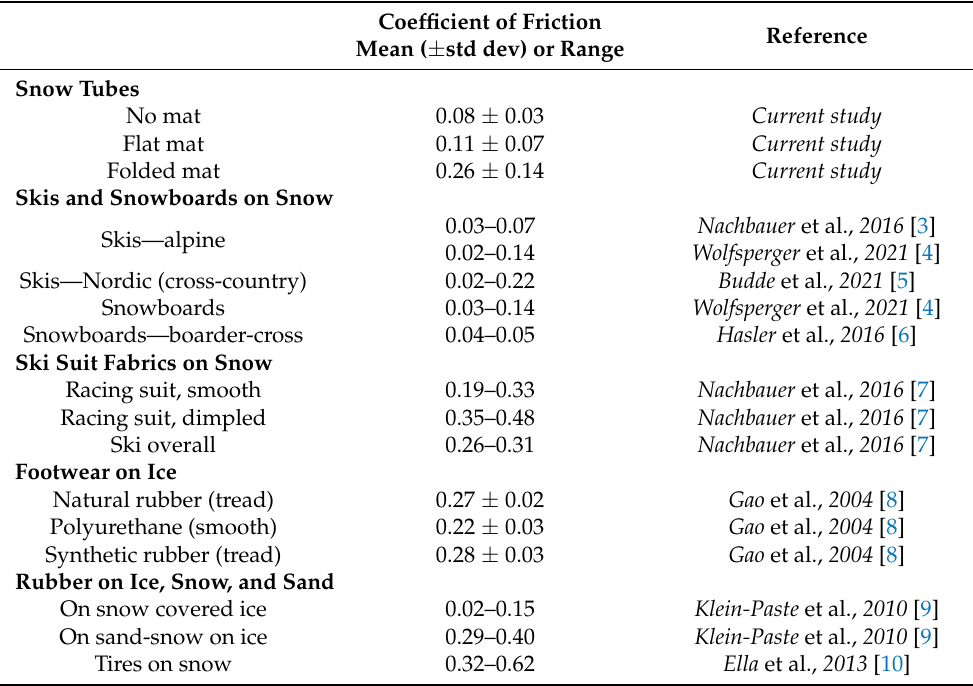
Table 2. Coefficients of friction for snow tubes on deceleration mats compared to other snow sports equipment, and footwear material, and tires on snow and ice. If the mean and standard deviation were not provided, the range is